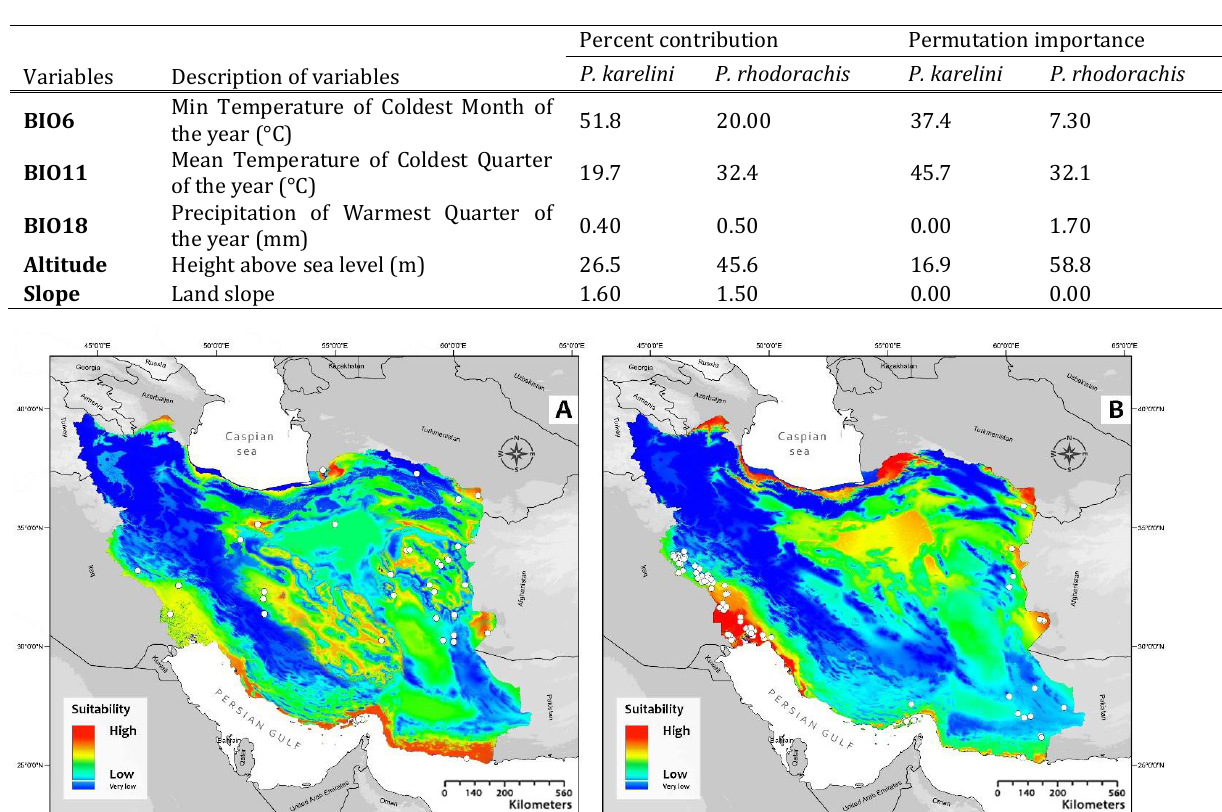
T ABLE 1. Permutation importance and Percent contribution of variables used in MaxEnt model for two species of P. karelini and P. rhodorachis .